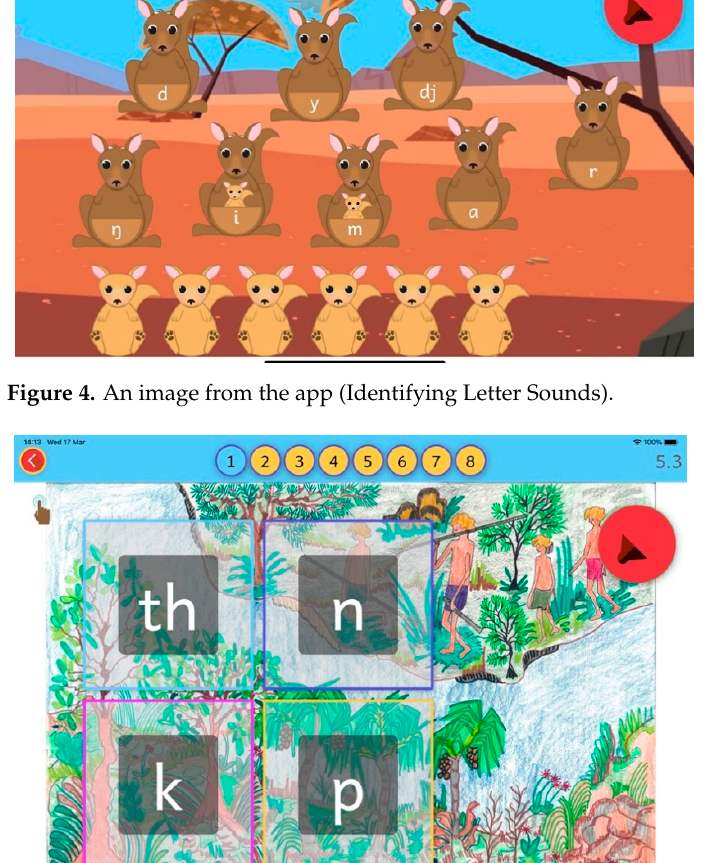
Figure 5. Culturally appropriate background to the app